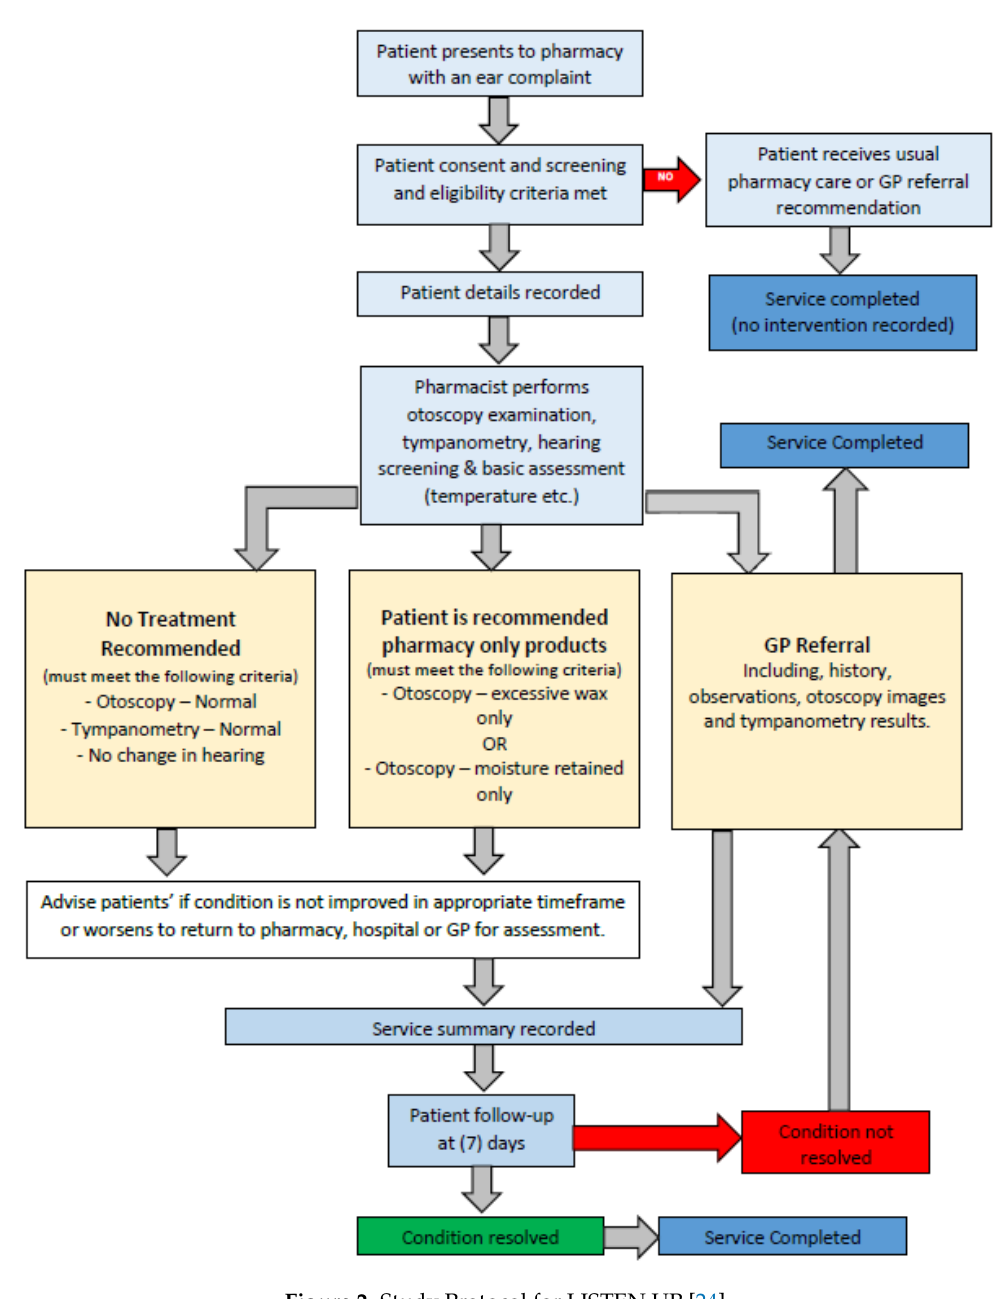
Figure 2. Study Protocol for LISTEN UP [24].